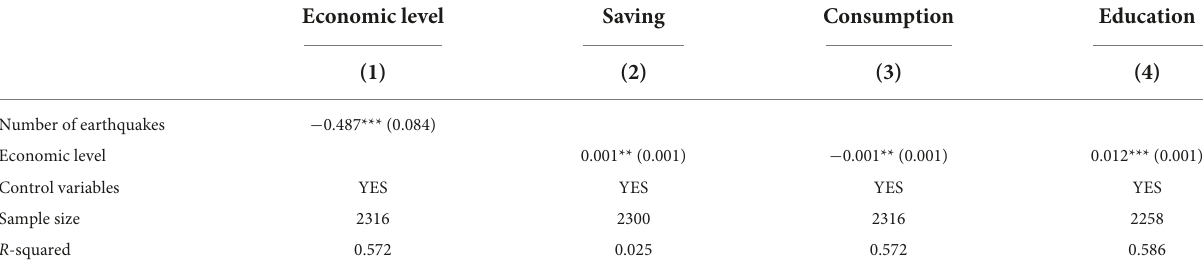
TABLE 11 Earthquake, economy and time